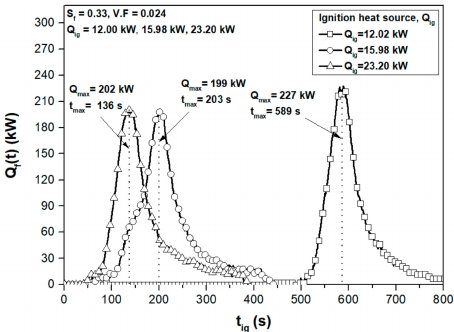
Figure 5. The results of the heat release rate with the variations of the ignition heat source for volume fraction 0.024 and scale factor